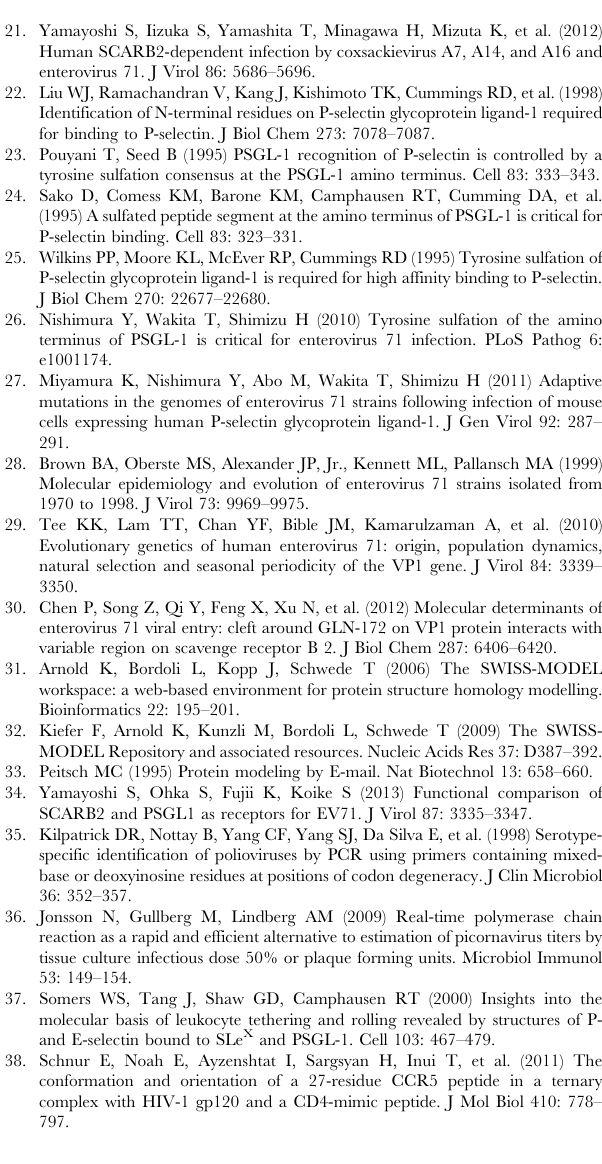
Figure S1 EV71–PSGL-1 binding assay using real-time RT- PCR. Viruses (5 6 10 7 viral genomes) were incubated with anti- VP1 mAb or PSGL-1-Fc and collected with protein G beads. Precipitated viruses were analyzed by real-time RT-PCR as described in Materials and Methods. Viral genome copies are expressed as the mean, and error bars indicate s. d. of three independent experiments. (A) Viruses were precipitated with anti- VP1 mAb to show the presence of virion in the sample. The amount of virus precipitated with nonspecific isotype control was considered as background binding (left). (B) Viruses were precipitated with PSGL-1-Fc. A control Fc chimeric protein (CTLA-4-Fc) was used as a negative control. Asterisks indicate a significant difference in specific binding to PSGL-1-Fc ( P , 0.01). Table S1 Codons and amino acids at VP1-98 and VP1-145 in 1702 EV71 sequences found in GenBank.